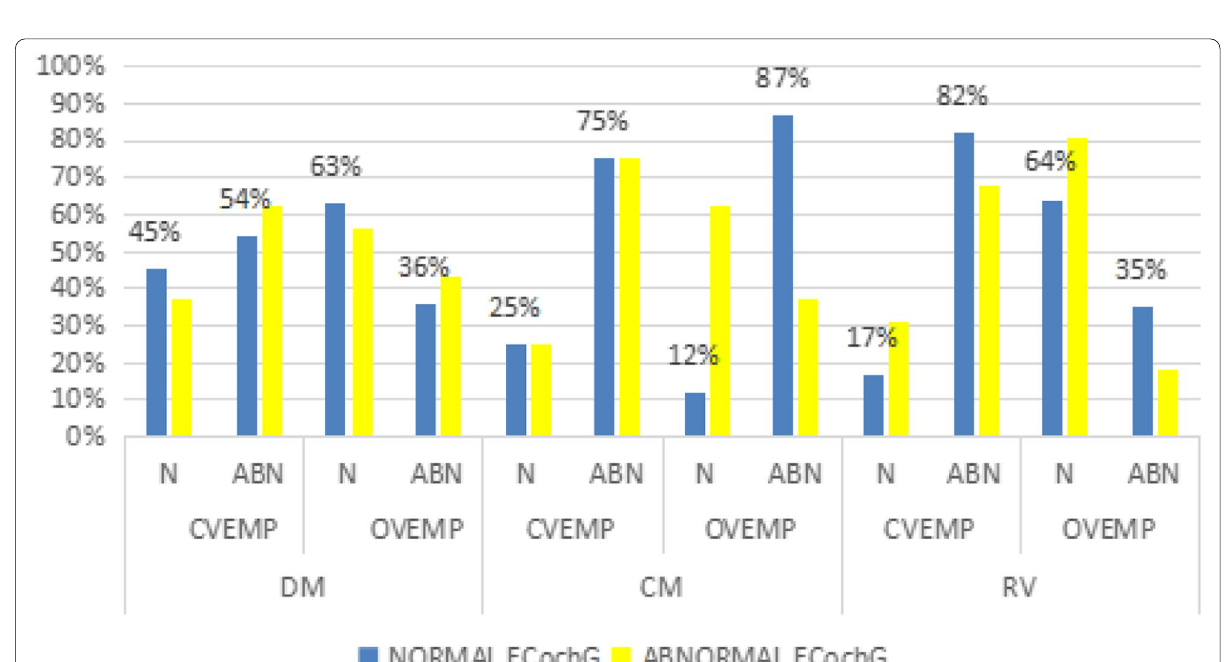
Fig. 6 Findings of C-VEMP and O-VEMP in patients with normal versus abnormal EcochG. This study showed 33% of patients with normal ECochG had abnormal